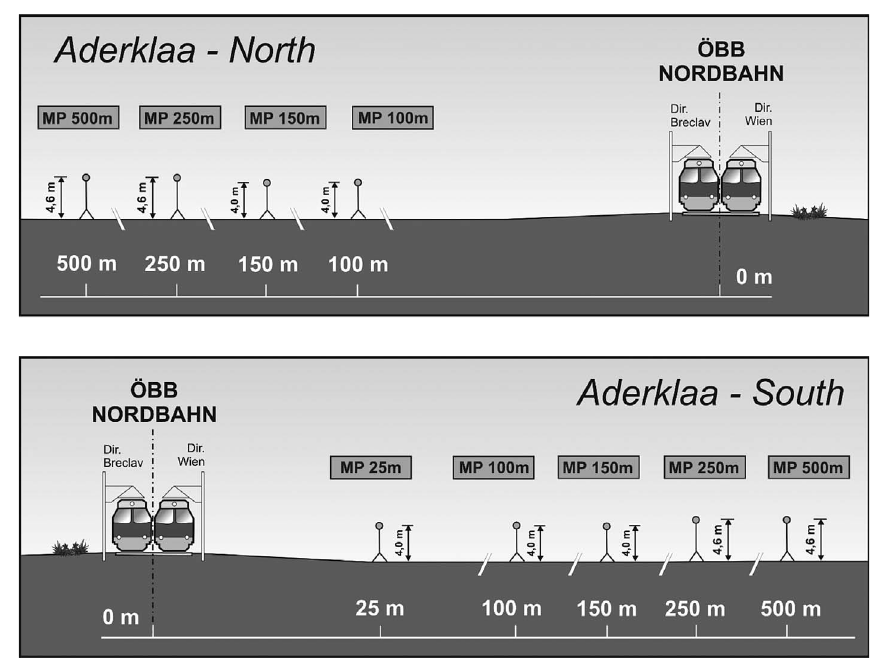
Figure 3. Railway line near Aderklaa with measurement positions north and south of the railway